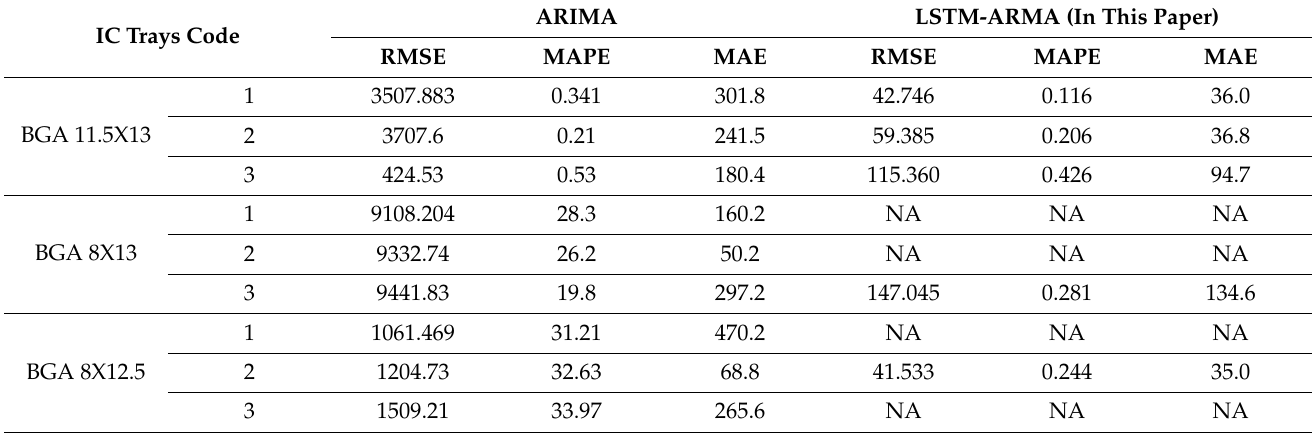
Table 11. Results of the comparison between traditional ARIMA and our proposed LSTM-ARMA for three IC